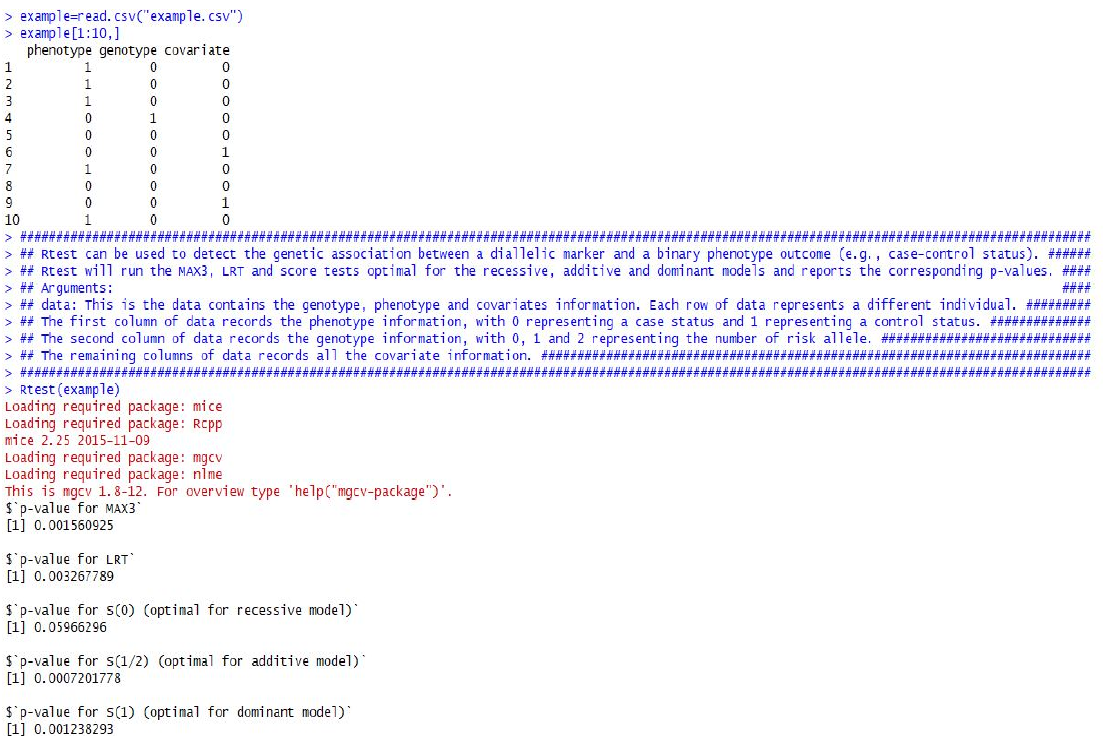
Figure 1. R code to analyze the example dataset.